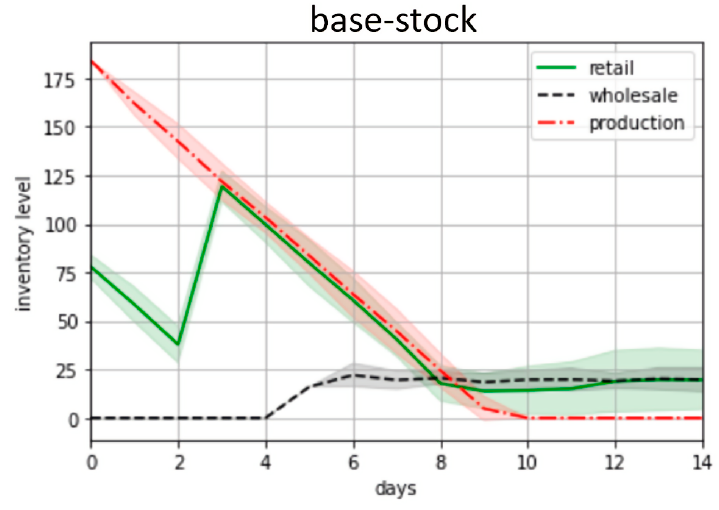
Figure 5. Inventory dynamics under the control of the base-stock policy during the first experiment.